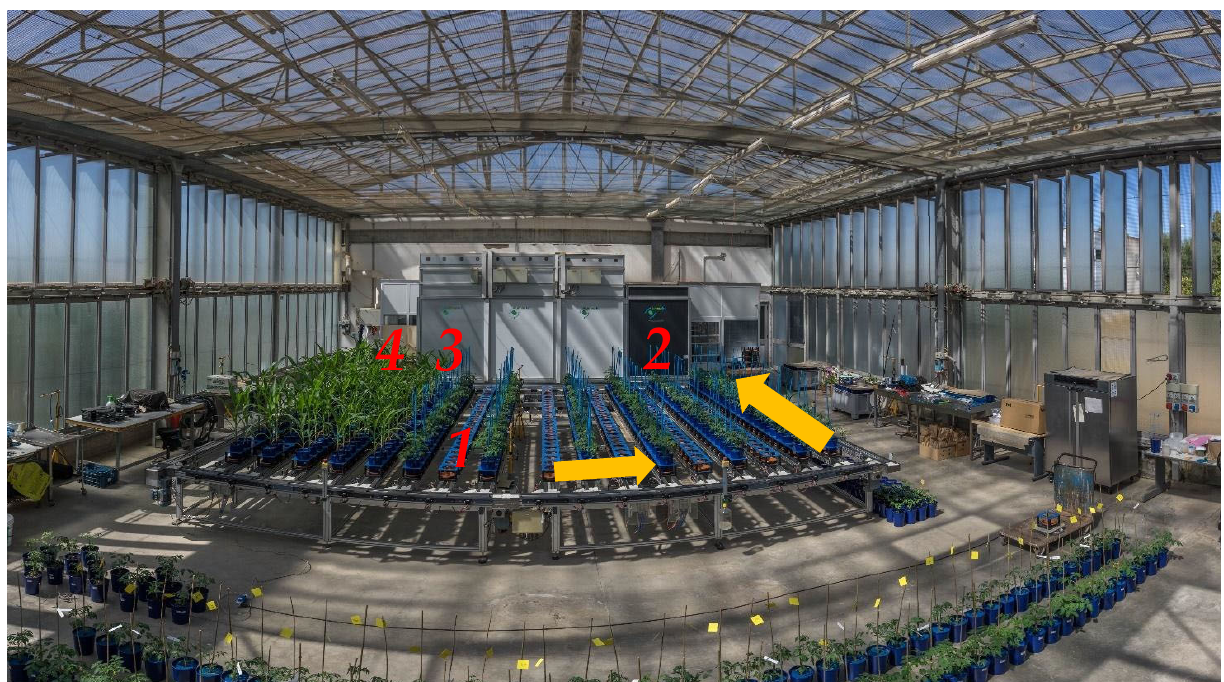
Figure 9. Plants located on the conveyor belt ( 1 ) were moved to visible camera ( 2 ) during the acquisition process. Subsequently, plants were moved to hyperspectral camera ( 3 ) and automatic irrigation system ( 4 ). Plants were left on the conveyor belt during the time between acquisition processes. The HTPP was based on a LemnaTec Scanalzer 3D system.